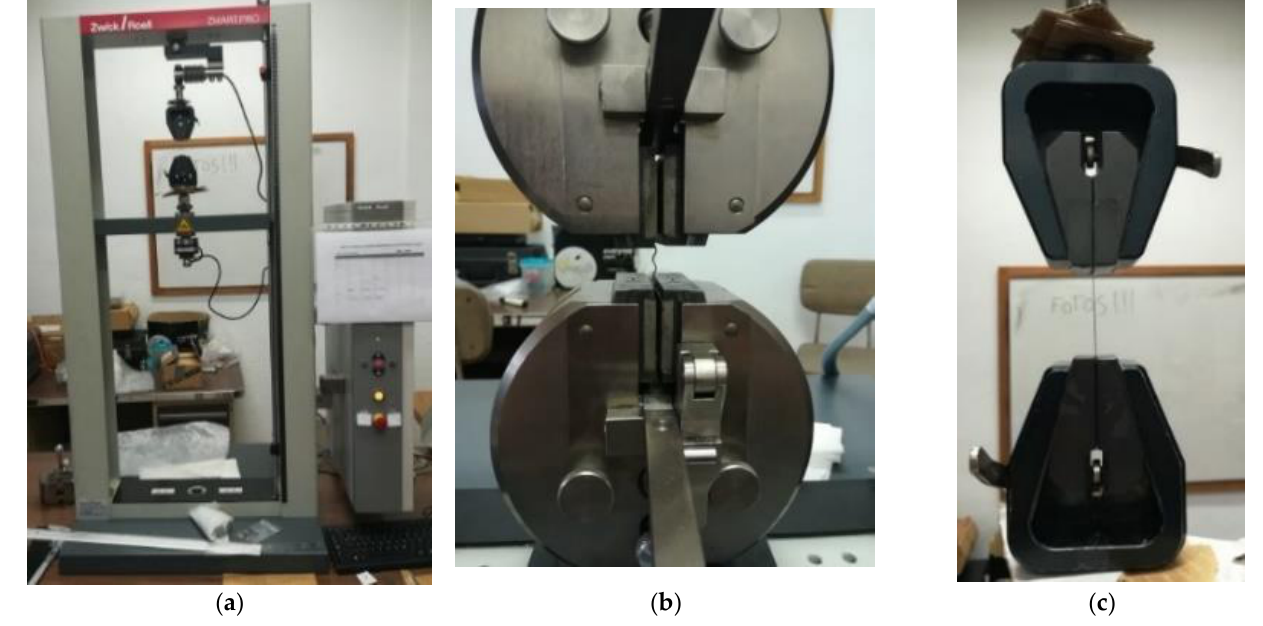
Figure 5. ( a ) Tensile strength machine, ( b ) load cell 200 N, and ( c ) load cell 10 kN.